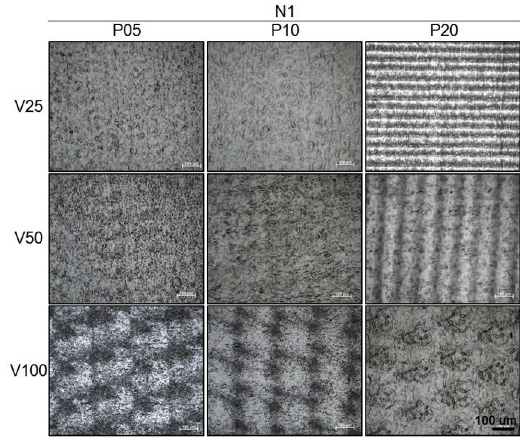
Figure 2. Evolution of the surface topography for one run of the laser (N=1) and different power (P) and speed (V). The scales are the same.